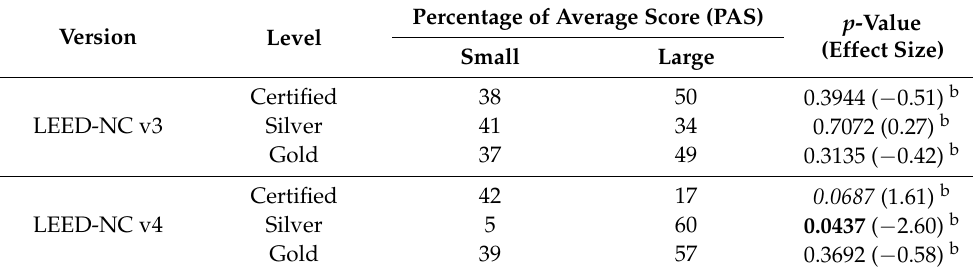
Table 11. LEED-NC v3/v4 office-type projects, green power